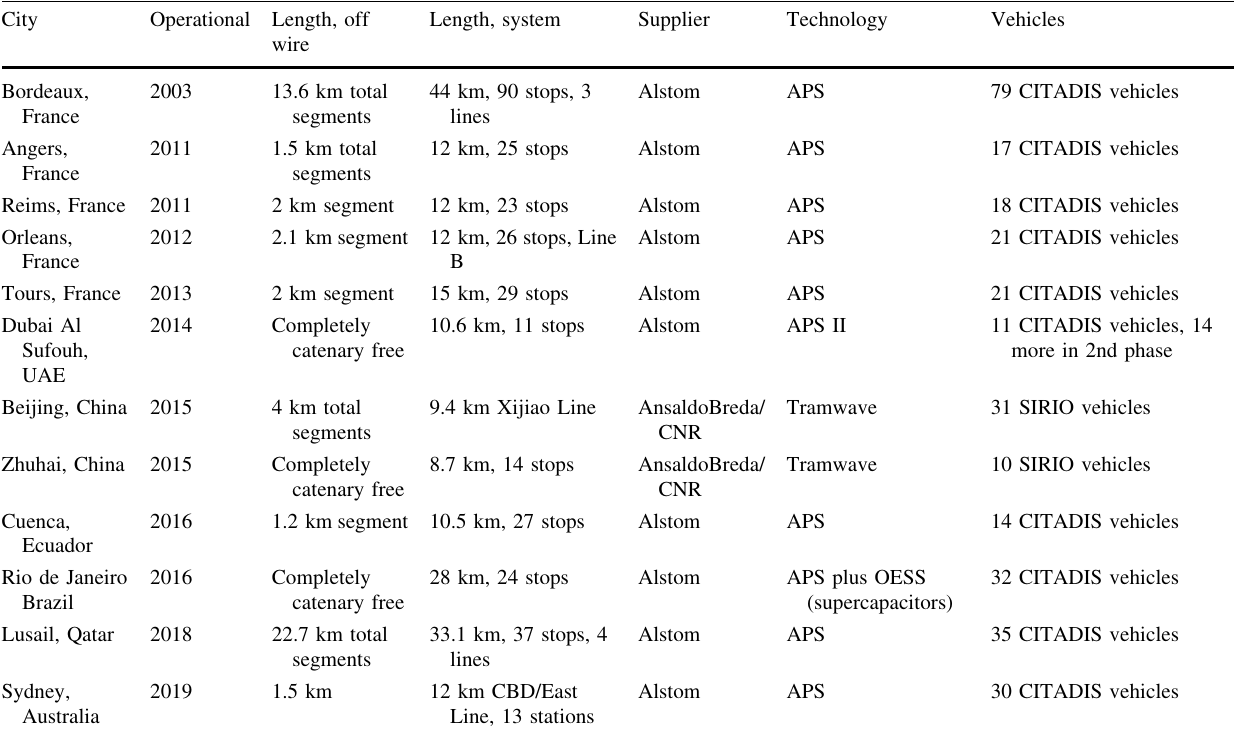
Table 2 Ground-level power supply systems ‘‘GLPS’’. ( Source : [9])